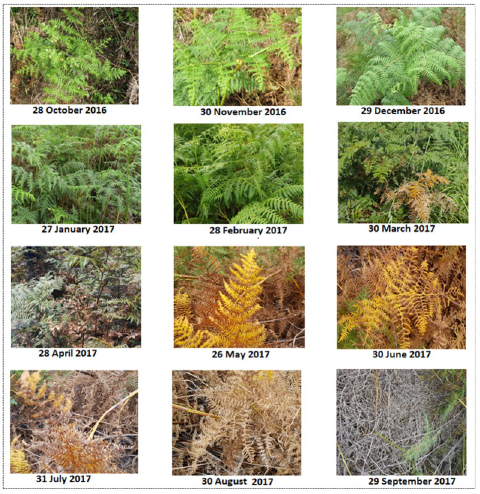
Fig 1. Phenological transformation of bracken fern appearance from October 2016 to September 2017 captured in Cathedral Peak study site.